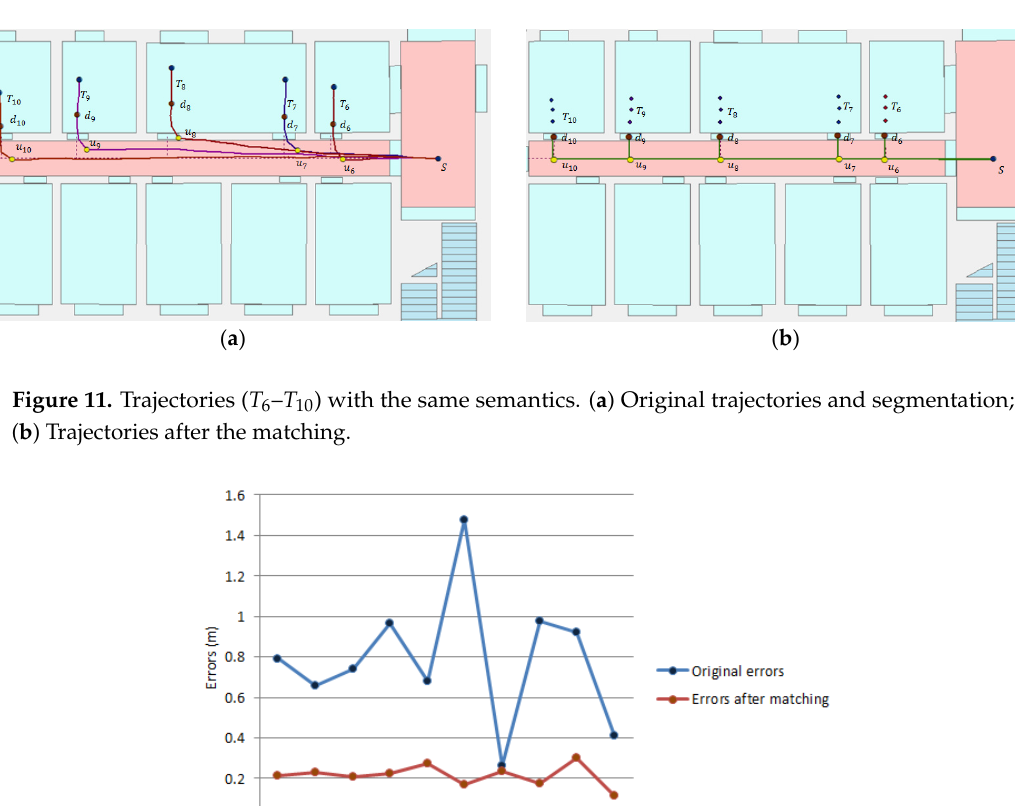
Figure 10. Trajectories ( T 1 – T 5 ) with the same semantics. ( a ) Original trajectories and segmentation; ( b ) Trajectories after the matching.